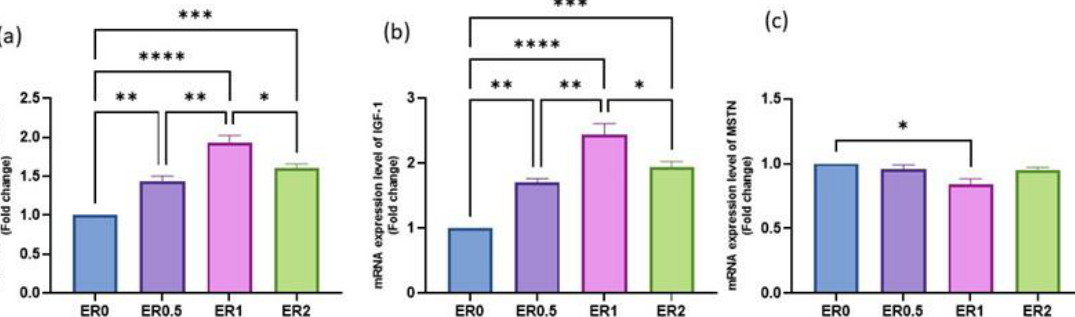
Figure 5. Gene expression profiles of ILGF-1 ( a ), GHr ( b ), and MSTN ( c ) in Red tilapia exposed to varying doses of ER in their diets. Asterisks on the data bars indicate statistically significant deviations when comparing the experimental and control groups. Values are expressed as mean ± SE from triplicate groups. p values of one-way ANOVA followed Tukey’s post hoc test for significant differences. p < 0.05 (*), p < 0.01 (**), p < 0.001 (***), and p < 0.0001 (****).